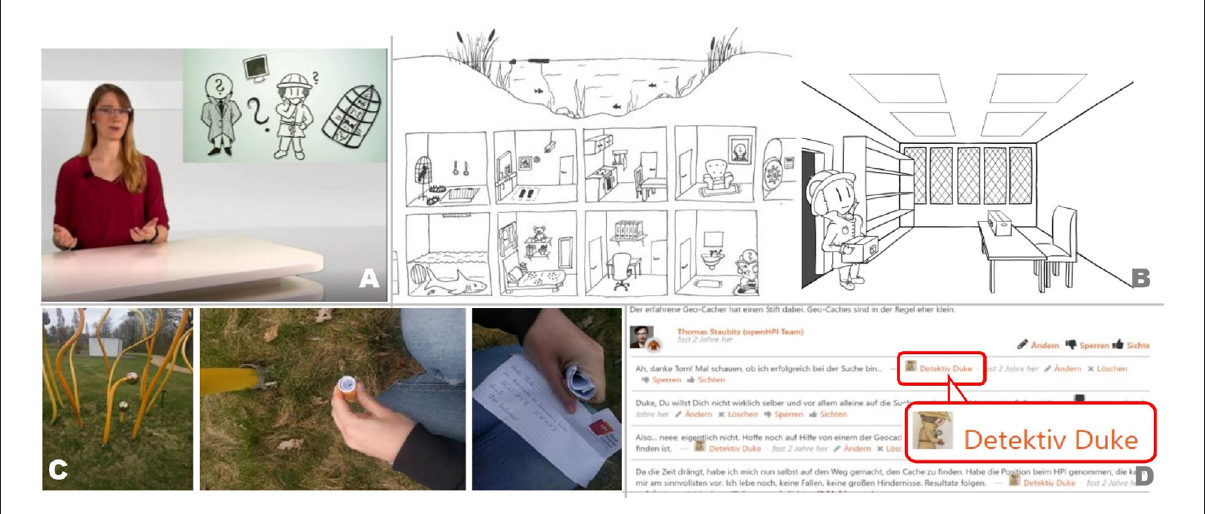
FIGURE2 Different elements of the course story: (A) story video including presenter and animated video, (B) illustrations of peer assessment task, (C) geocache presentation, (D) story characters posting in the course forum ( Hagedorn et al., 2019).